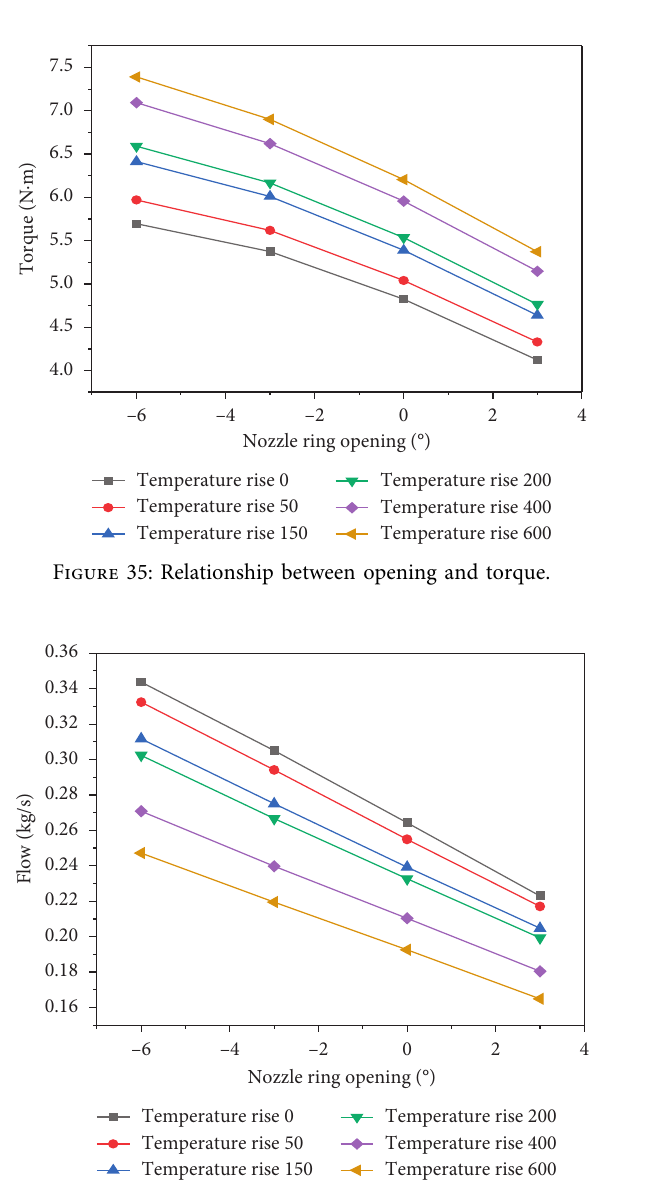
Figure 36: Relationship between opening and